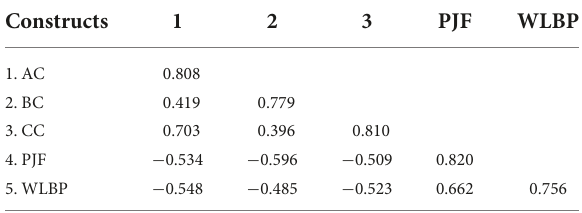
TABLE 3 Fornell and Larcker criteria.